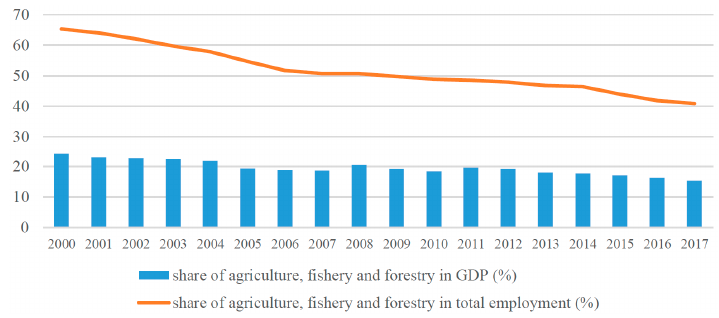
Figure 2. Share of agriculture in the GDP and employment (Data from: https://lienvietpostbank.com.vn/ [3], accessed on 26 June 2020).